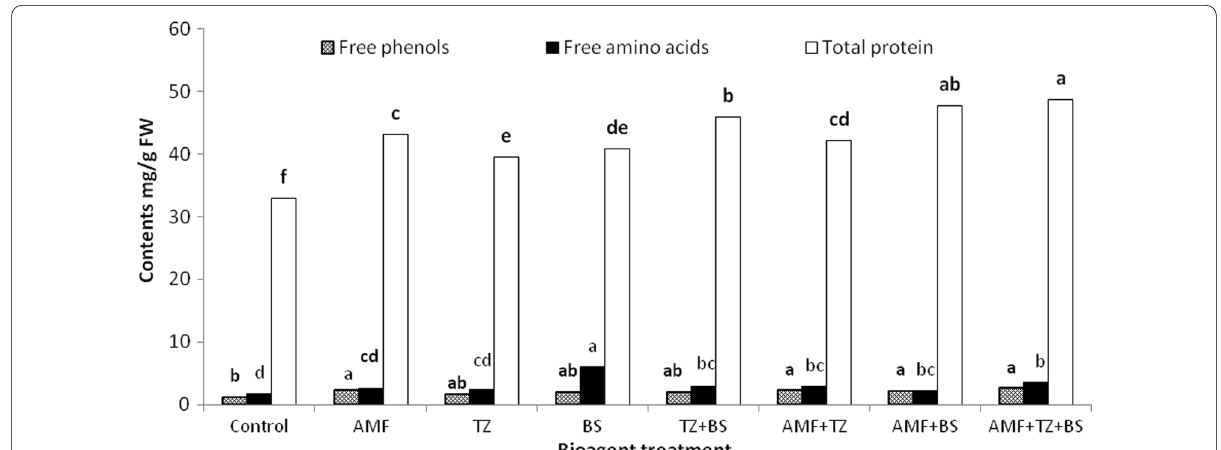
Fig. 2 Effect of AMF and PGPRs on the contents of free phenolic compounds,total free amino acids and total protein. Bars with different letters are significantly different (LSD, P > 0.05). Arbuscular Mycorrhizal fungi (AMF), Trichoderma harzianum ( TZ ) , Bacillus subtills (BS), control (without